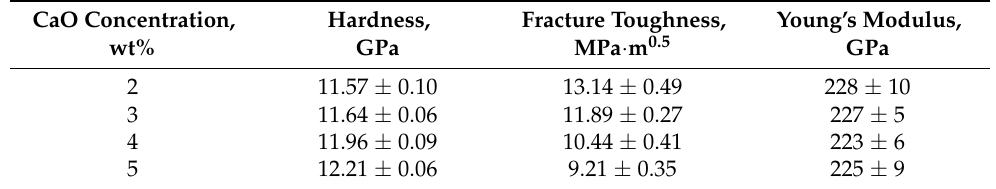
Table 1. Mechanical characteristics of CaO-stabilized zirconia ceramics of a baddeleyite origin sintered at 1300 ◦ C containing different dopant